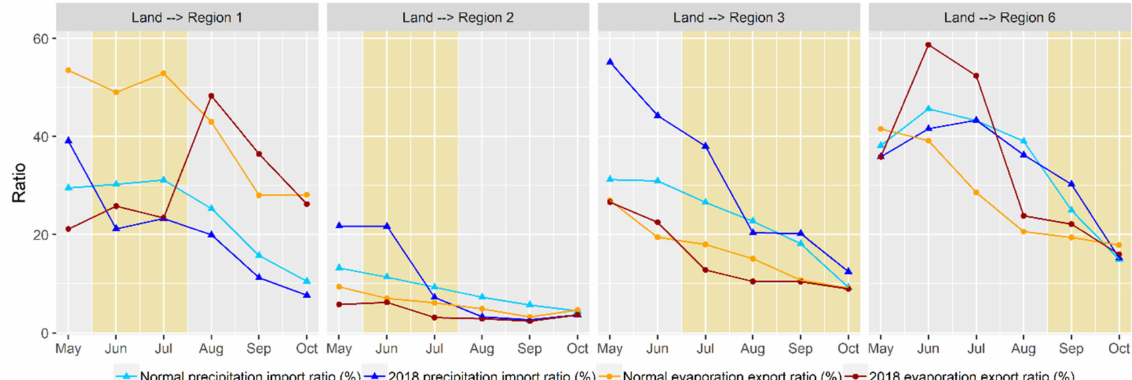
Figure 4. The 2018 monthly evaporation export and precipitation import ratios (Equations (3) and (4)) with land being the source region while drought regions 1, 2, 3 and 6 are being the sink regions. The location of these regions is indicated in Figure 1. A yellow shading is applied when the month experiences drought (i.e., SMC of that month and NDVI of the following month percentiles <33.4). Note, regions 4 and 5 did not experience a strong drought (Figures 1–3) and were, therefore, not included here.